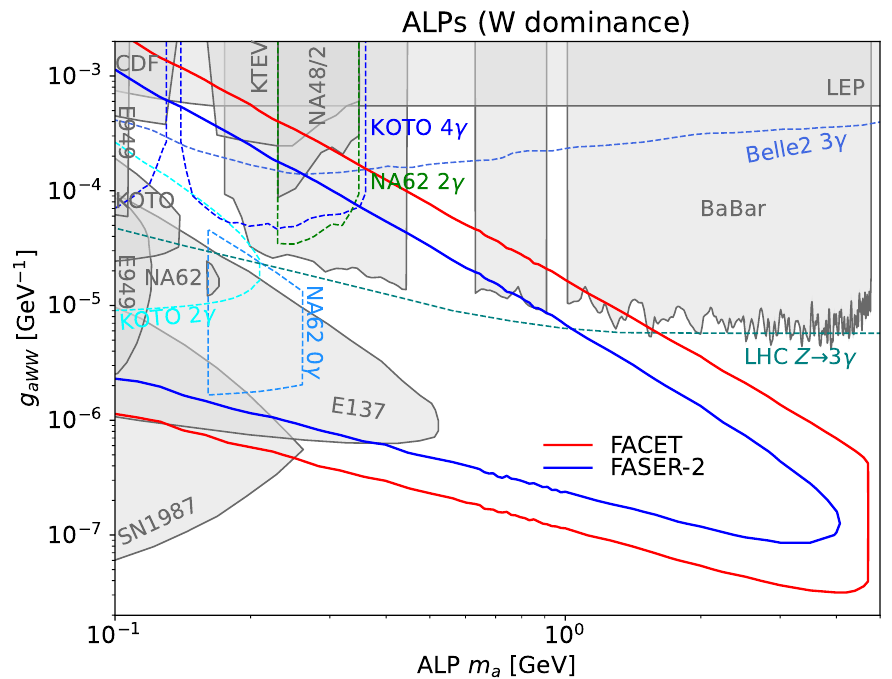
Figure 5 . FACET sensitivity to ALPs in the W -dominance model (3 event contours), as a function of mass and coupling, as calculated with Foresee [38]. The gray-shaded regions are excluded by current bounds, while dashed lines correspond to projected sensitivity of various experiments, as calculated in refs. [57, 58]. The BaBar limits are from ref. [59]. More details can be found in refs. [60, 61] and references therein.